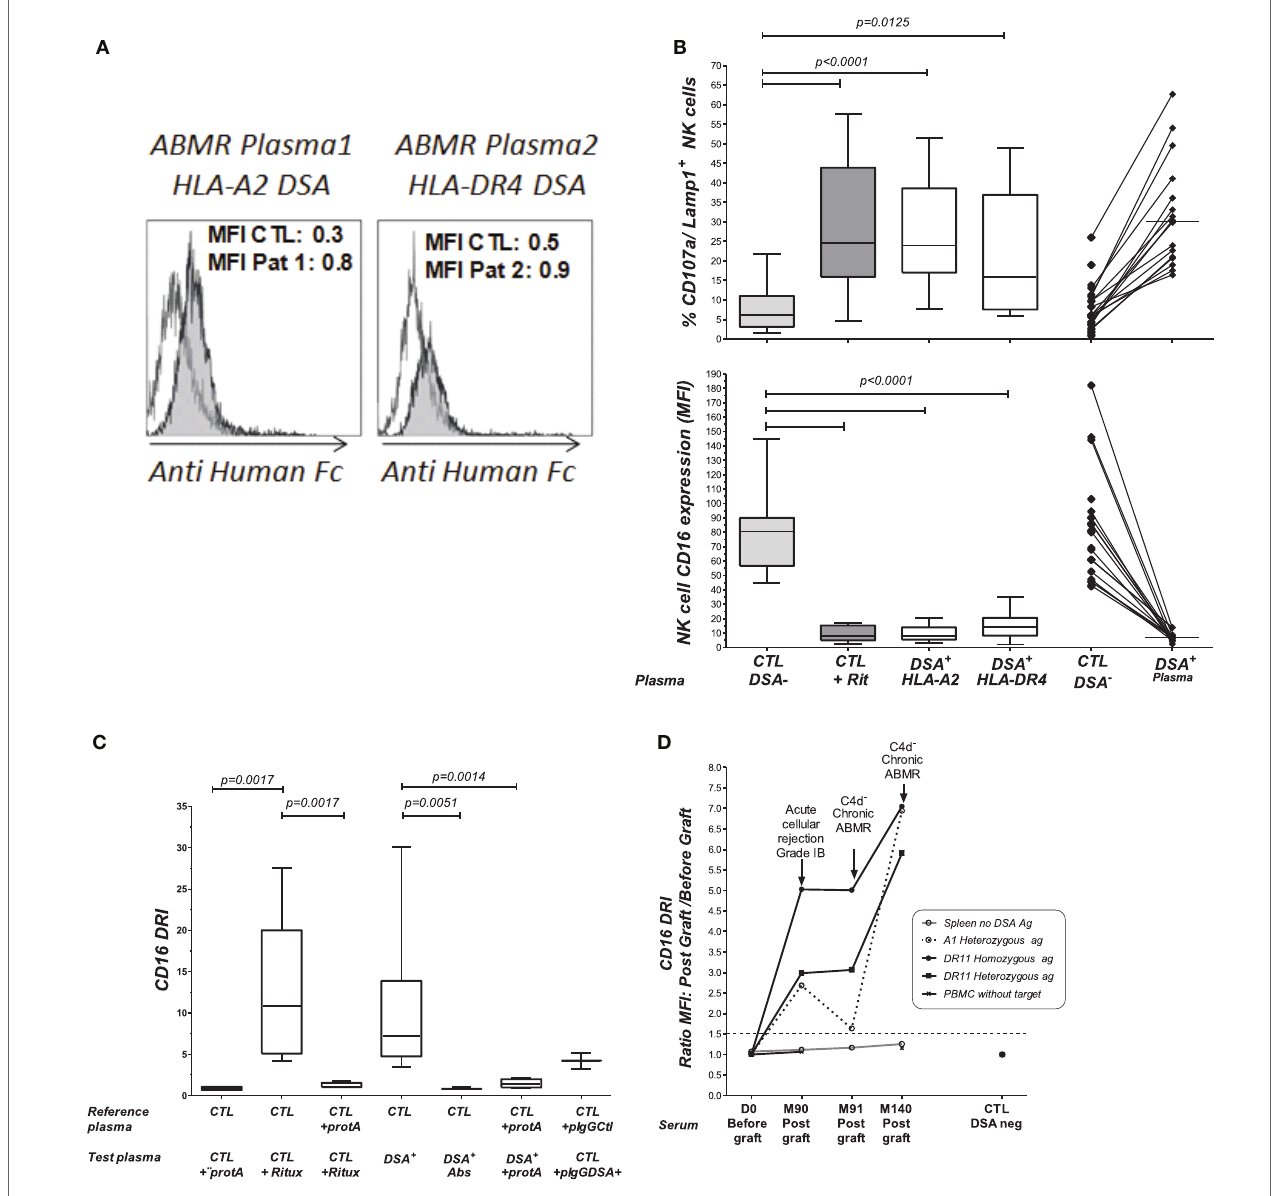
FigUre 3 | comparative analysis of rituximab and Dsa-specific nK cell activation . (a) Plasmapheresis samples were obtained during plasma exchange therapy from two patients with circulating DSAs and a biopsy-proven ABMR. The binding of anti HLA-A2 (patient 1, Pat1) or anti HLA-DR4 DSA (patient 2, Pat2) to B cell targets was revealed by flow cytometry cross-match (FCMX) using a secondary antibody (gray shaded area). FCXM was analyzed in reference to binding and was observed when B cells were coated with the control plasma, showing no humoral reactivity (white area). MFI, median fluorescence intensity. (B) Comparative analysis of rituximab and DSA-induced NK cell activation toward target cells expressing HLA alloantigens. Flow cytometric analysis of antibody-mediated CD107a/ Lamp1 (upper panel) and CD16 (MFI) (lower panel) expression was performed using NK cells prepared from distinct third-party healthy donors after incubation with HLA-A2 homozygous and DR4 heterozygous B cell targets and HLA-A2 DSA + plasma ( n = 17) or HLA-DR4 DSA + plasma ( n = 11). CTL, control plasma with no detectable anti HLA antibodies. (c) NK-CHAT analysis of DSA + plasma. CD16DRI was evaluated using effector cells exposed to B cell targets in the presence of rituximab, DSA + plasma, or DSA − CTL plasma. The specificity of antibody-driven CD16 engagement was analyzed by the addition of Protein A (53), by prior platelet absorption (Abs) of the anti-HLA antibodies in plasma, or through the use of IgG purified from ABMR plasma (pIgG DSA + ) or control plasmas with no detectable HLA antibodies (pIgG CTL). (D) CD16DRI was used to evaluate the reactivity of serum samples obtained during the follow-up period of KTRs toward four different allogeneic splenic cells from the day of transplant (D0) to months (M) 90, 91, and 140 after transplant. The target splenic cells were selected according to the presence or absence of HLA antigens recognized by anti HLA-A1 or HLA-DR11 DSAs: (o) no relevant HLA antigen, (---) HLA-A1 heterozygote, and ( ) HLA-DR11 homozygous ( ) or HLA-DR11 heterozygous antigens. An enhanced CD16DRI of NK cells that were exposed to splenic cells expressing DSA cognate HLA alloantigen was obtained using serum obtained at M90 from this KTR patient at the time of acute cellular rejection diagnosis. Persistent elevated CD16DRI levels were obtained using serum obtained at the times of two consecutive episodes of C4d − diagnosis of chronic ABMR, which occurred at M91 and M140 after transplant. The values of CD16 MFI obtained when effector PBMCs exposed to serum in the absence of splenic cells served as controls for baseline activity (